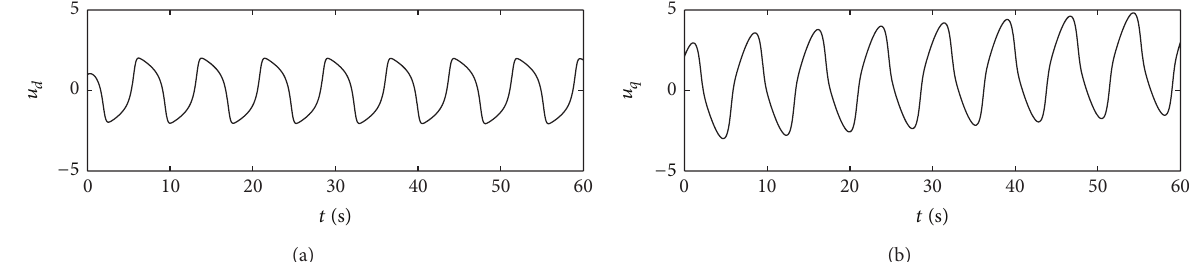
Figure 3: System control inputs 𝑢